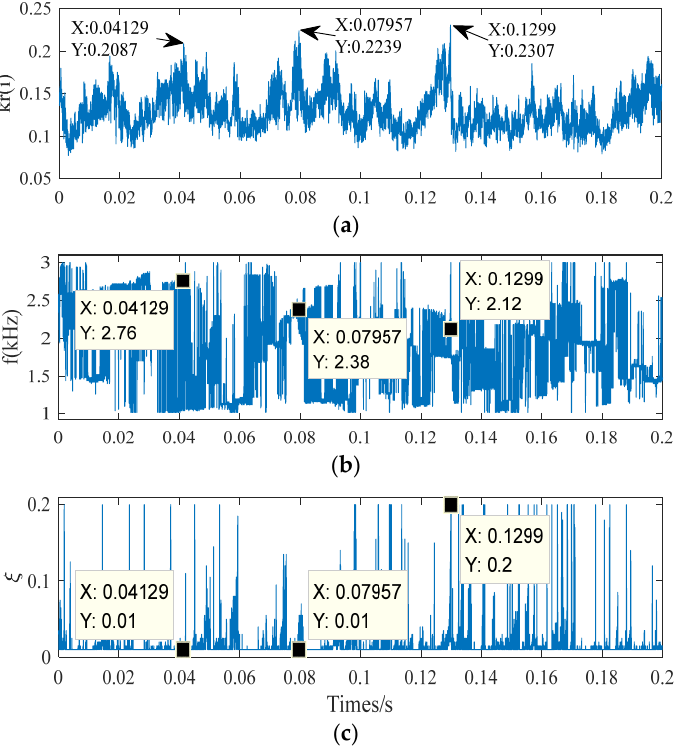
Figure 7. Correlation filtering result of original signal: ( a ) The correlation coefficient κ r between the base atom and the original signal; ( b ) Resonance frequency of each point in κ r ; and ( c ) Damping ratio of each point in κ r .